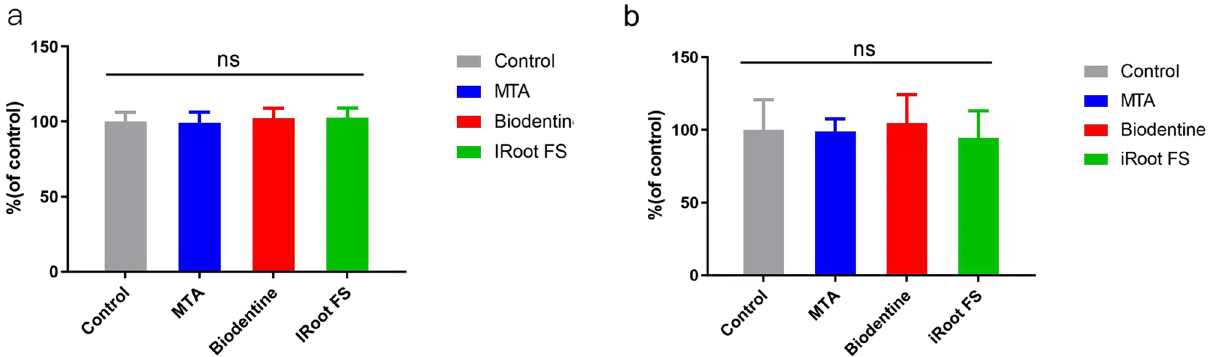
Figure 2. Outcome of carry-over effect test against ( a ) E. faecalis and ( b ) P. gingivalis.